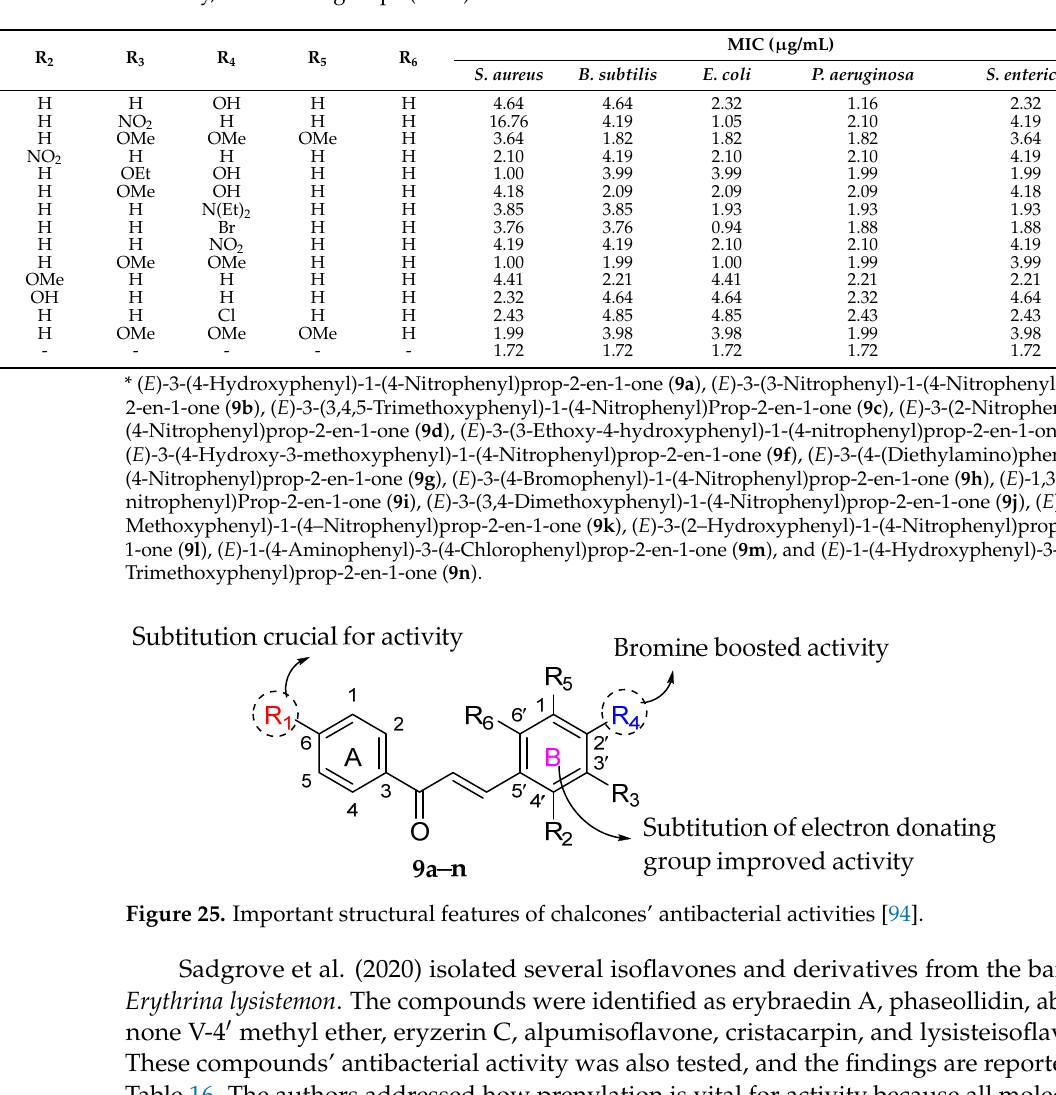
Table 15. Antibacterial activity of the substituted chalcones contaning nitor, amino, hydroxyl, meth- oxy, and chloro groups ( 9a – n ).